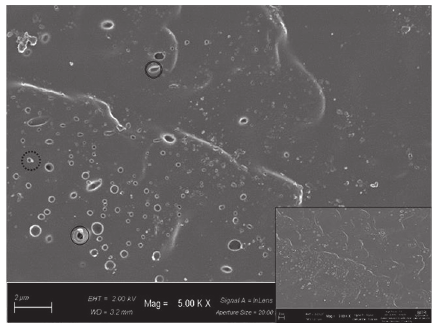
Figure 6: Scanning Electron Microscopy (SEM) image of wet phase inverted Au/Ag-PAA film. The main image shows the enlarged image of the solid circled part of the inset at a magnification of 5000x. The surface of the film shows well-dispersed gold (circles with a double line), silver nanoparticles (circles with a dashed line), and pores on the polymer surface (circles with a single line).